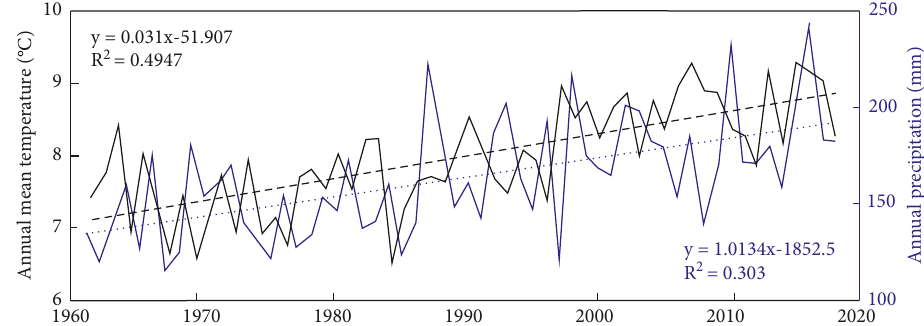
Figure 3: Variation trends of temperature and precipitation in the XUAR during